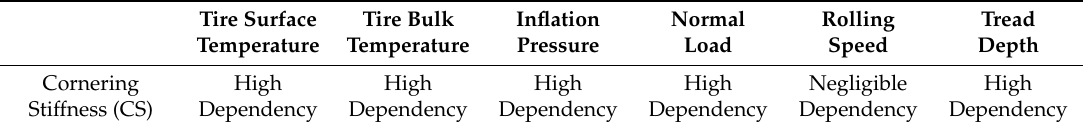
Table 5. Summary of dependencies.